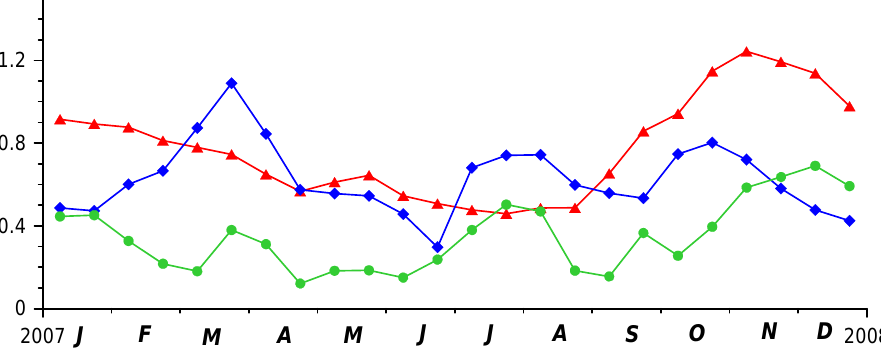
Fig. 24. Temporal evolution of the basin averaged surface chlorophyll-a (mgm ∗∗ 3 ) concentration for the deep part of the basin derived from Figure 24 Temporal evolution of the basin averaged surface chlorophyll-a (mg/m**3) modeling (blue line), SeaWiFS data (red line) and RMS deviation (green line). concentration for the deep part of the basin derived from modeling (blue line), SeaWiFS data (red line) and RMS deviation (green line).